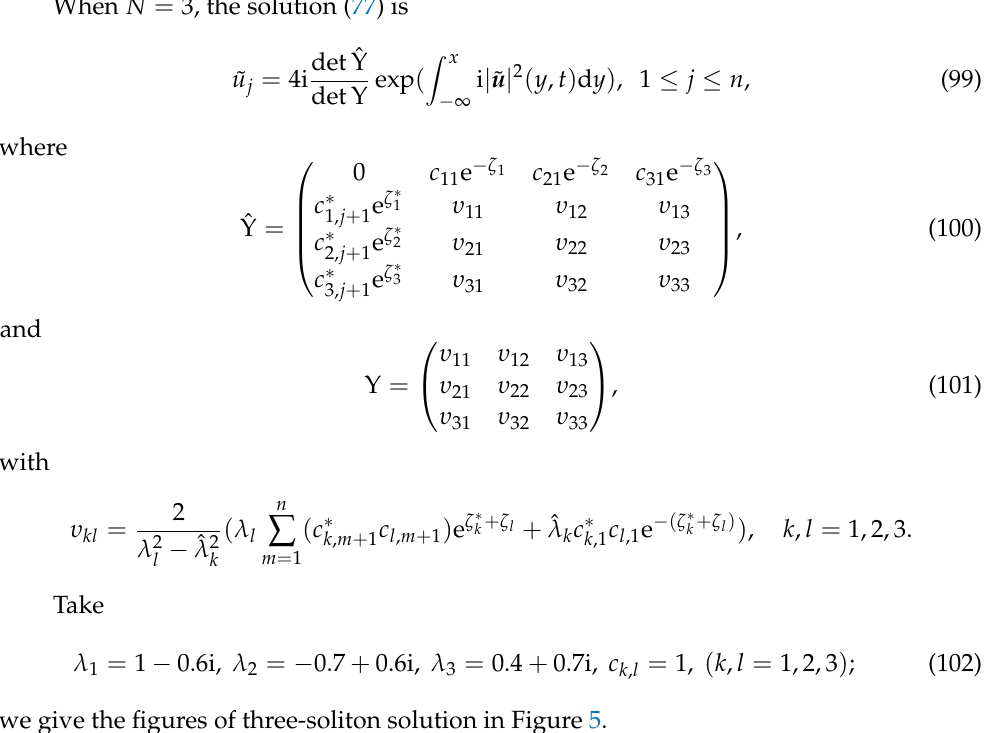
) = Re ( λ 4 ) + 2Re 2 ( λ 2 2 1